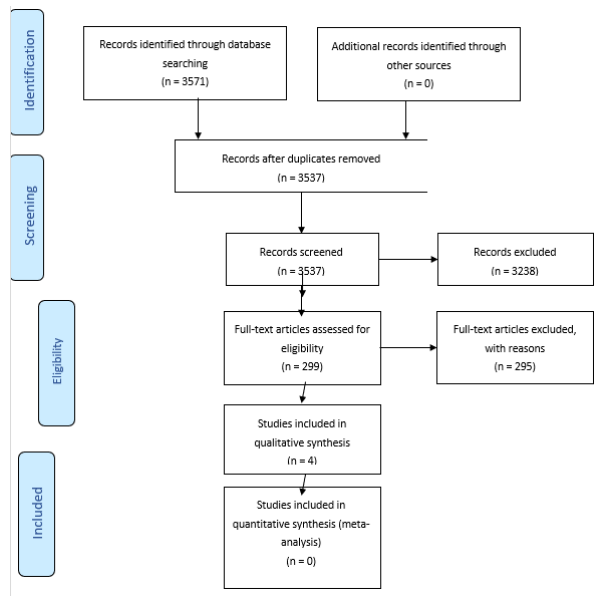
Figure 1. PRISMA 2009 Flow Diagram.